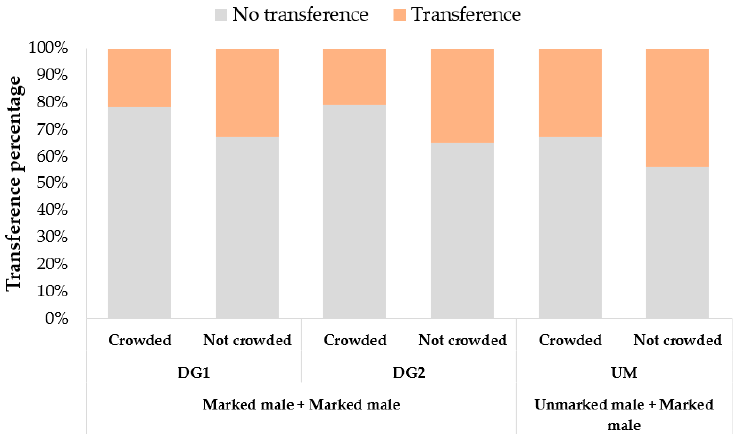
Figure 3. Transference of fluorescent powder (percentage) among Ae. aegypti males under crowded (N: 150 males) or not crowded (N: 30 males) conditions and different combinations (marked male + marked male, unmarked male + marked male). DG1 are marked males that received powder from a DG2 marked male, DG2 are marked males that received powder from a DG1 marked male, and UM are unmarked males that received powder from a DG1 marked male.